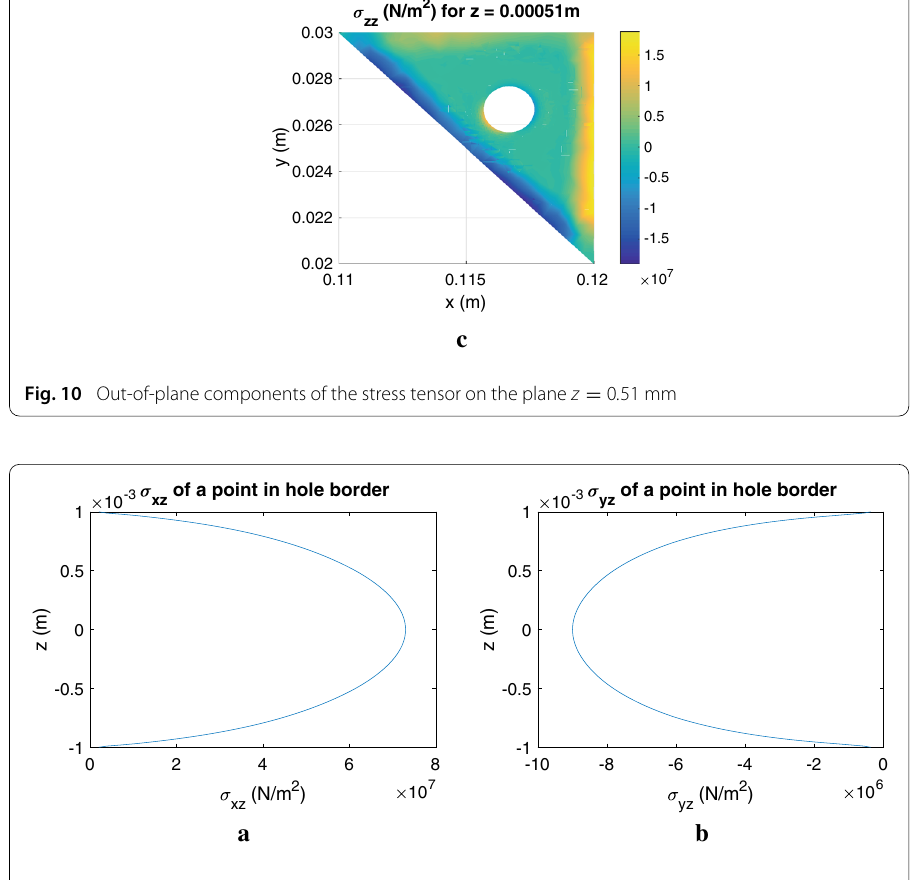
solution has been computed using a mesh as fine as the one considered to describe the enriched solution at the patch